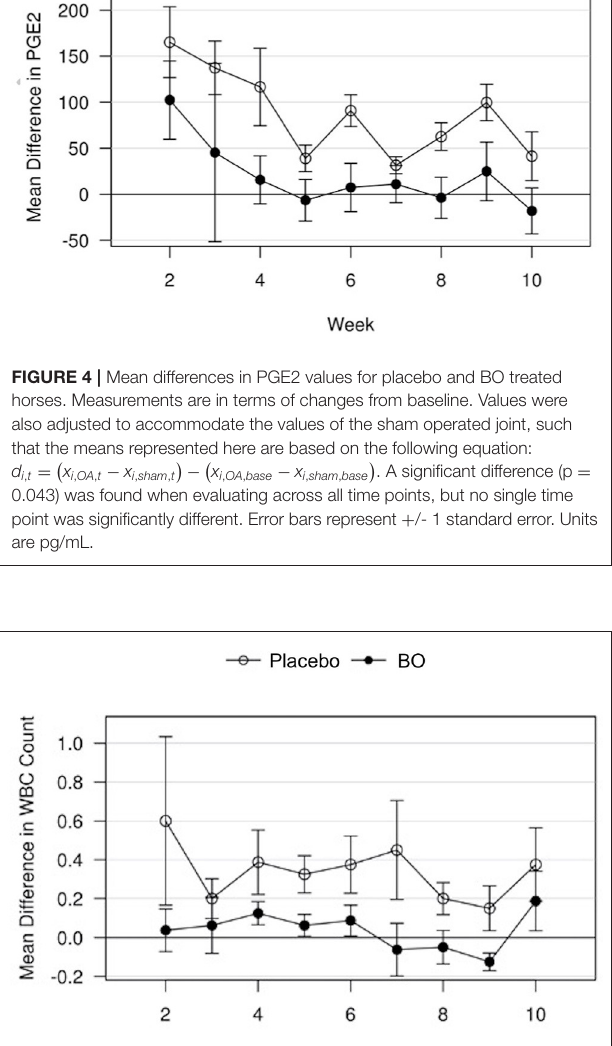
and total radiographic score ( p = 0.001) for the horses